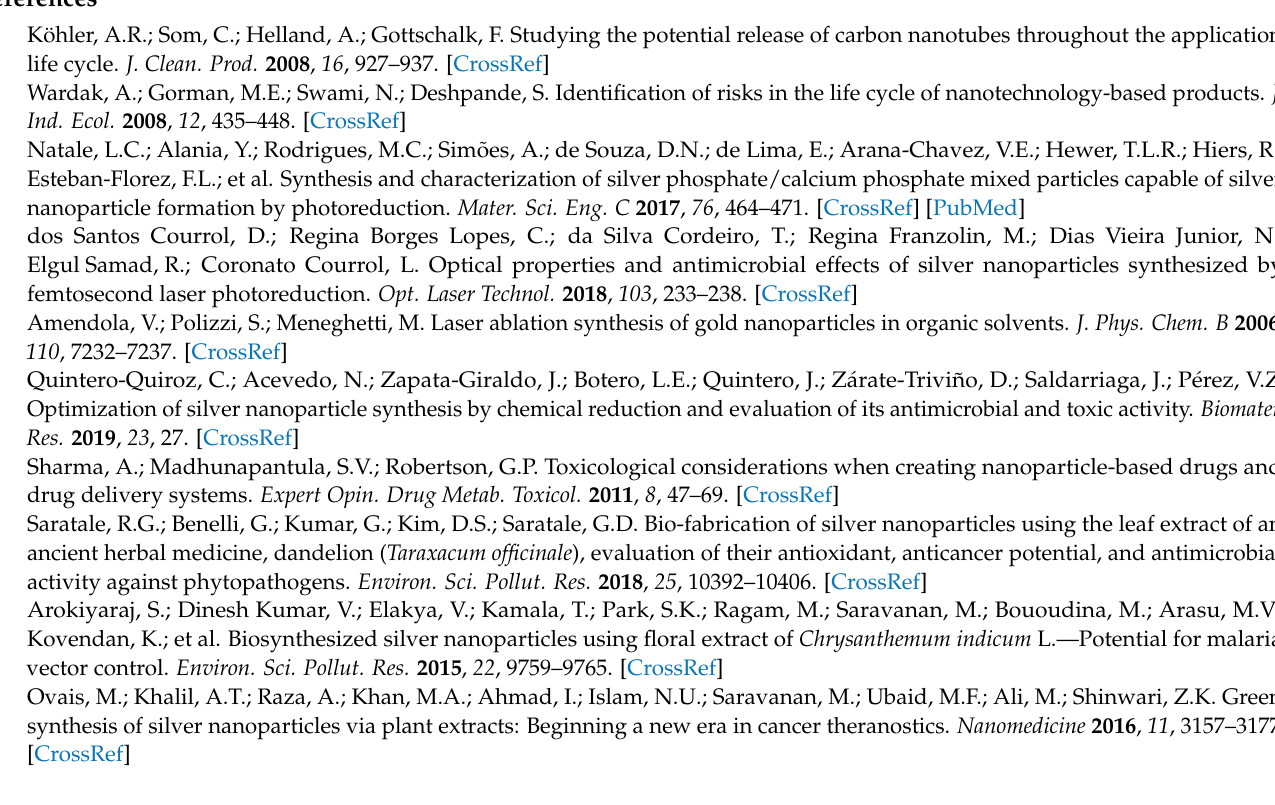
Figure S2: Parametric study for optimal laser processing on the glass. (a) Patterning result according to laser power and scanning speed, (b) sheet resistance change by changing the laser power at fixed scanning speed (5 mm/s), and (c) sheet resistance change with different pitch of grid pattern with 85 mW laser power and 5 mm/s scanning speed; Figure S3: Parametric study for optimal laser processing on the PDMS. (a) Patterning result according to laser power and scanning speed, (b) sheet resistance change by changing the laser power at fixed scanning speed (3 mm/s), and (c) sheet resistance change with different pitch of grid pattern with 35 mW laser power and 3 mm/s scanning speed; Table S1: Optimal fabrication parameter for high electrical conductivity; Figure S4: Transmittance spectra of the meshed pattern on PDMS. (a) Optical image of the meshed-type pattern, (b) transmittance result with different pitches of pattern, and (c) relation between transmittance and sheet resistance at different pitches; Figure S5: Microscale crack generation after the repeated bending; Figure S6: Fractal structure fabrication for durability against physical/mechanical deformation. (a) Schematic of fractal structure and geometry of subdivision, and (b) image of fabricated fractal structure; Figure S7: Adhesion test for mechanical stability between the pattern and substrate. Image of (a) tape-pull test and (b) ultrasonication test result of the pattern on glass (left) and PDMS